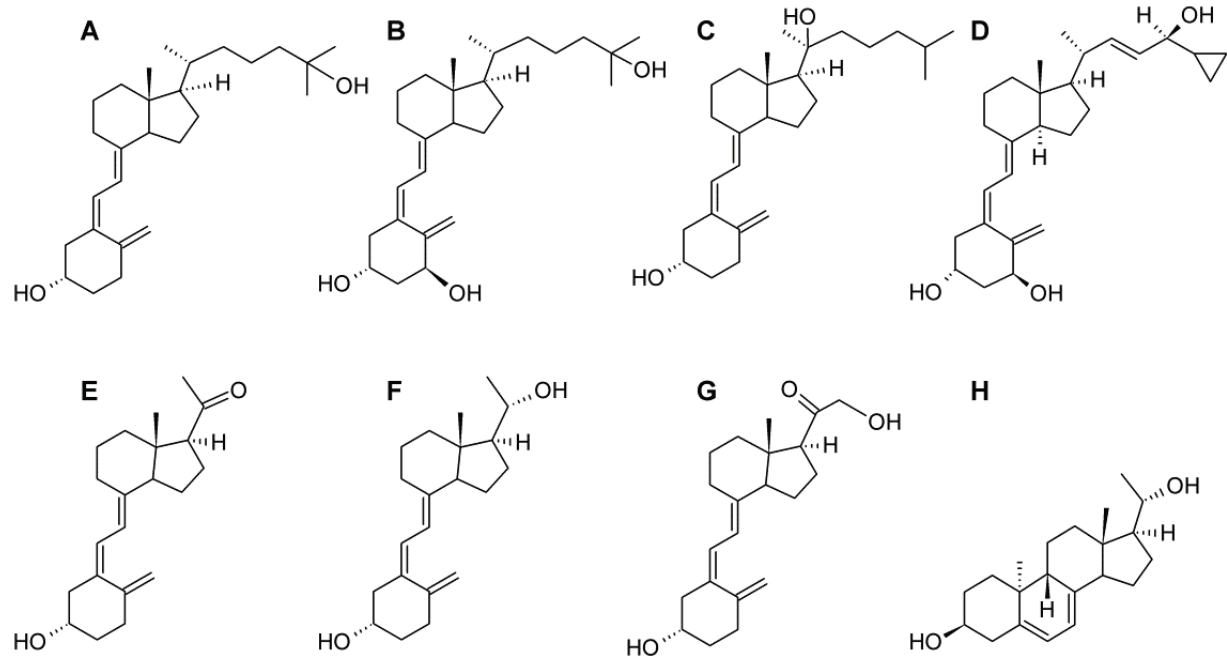
Figure 9. Chemical structures of the Vitamin D analogs tested. ( A ) 25(OH)D 3 ; ( B ) 1,25(OH) 2 D 3 ; ( C ) 20(OH)D 3 ; ( D ) calcipotriol; ( E ) pD; ( F ) 20(OH)pD; ( G ) 21(OH)pD; ( H )